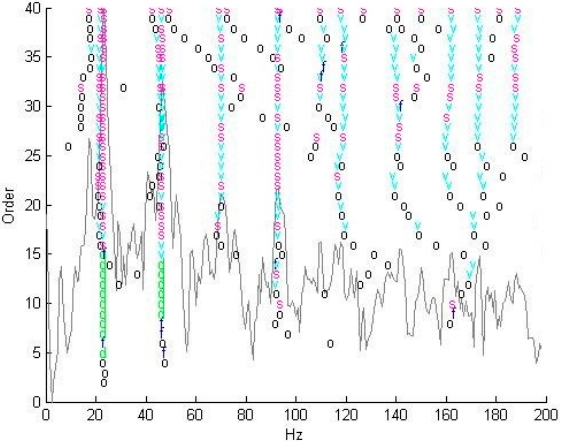
Figure 2. Determination of natural frequency from the stabilization diagram.